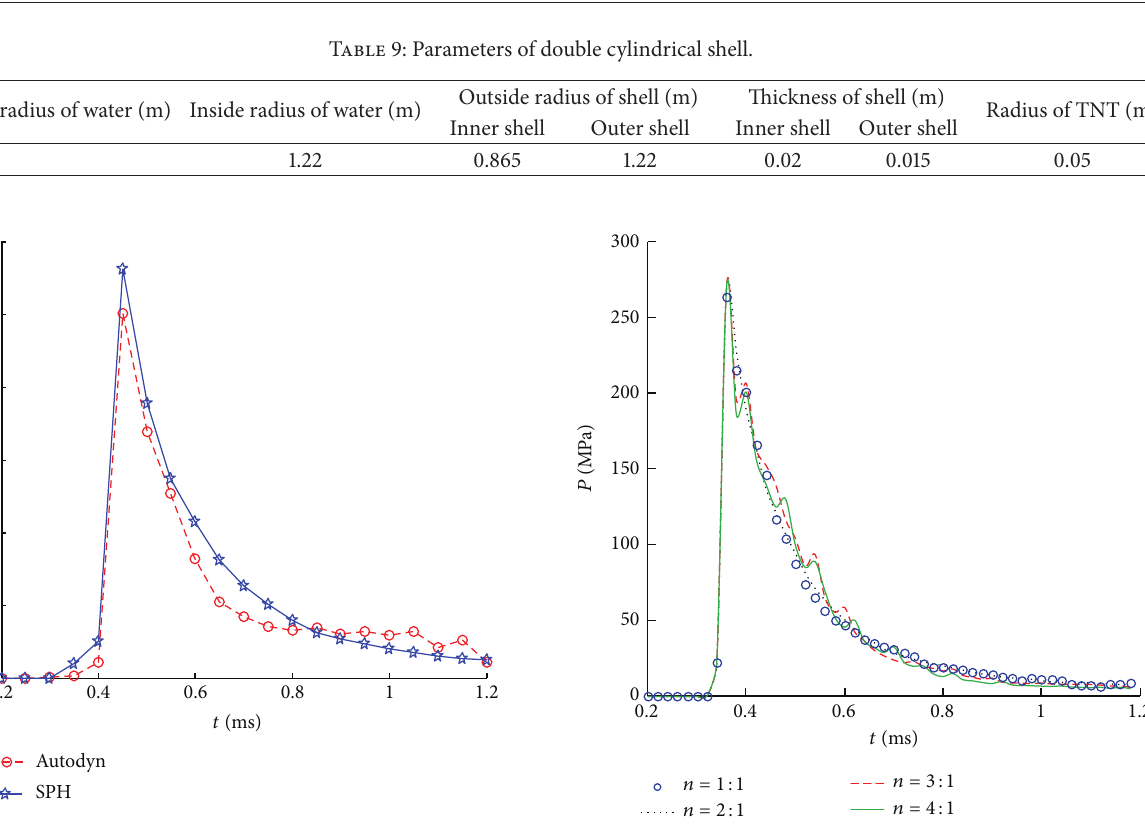
Figure 4: The pressure-time curves of test point A.